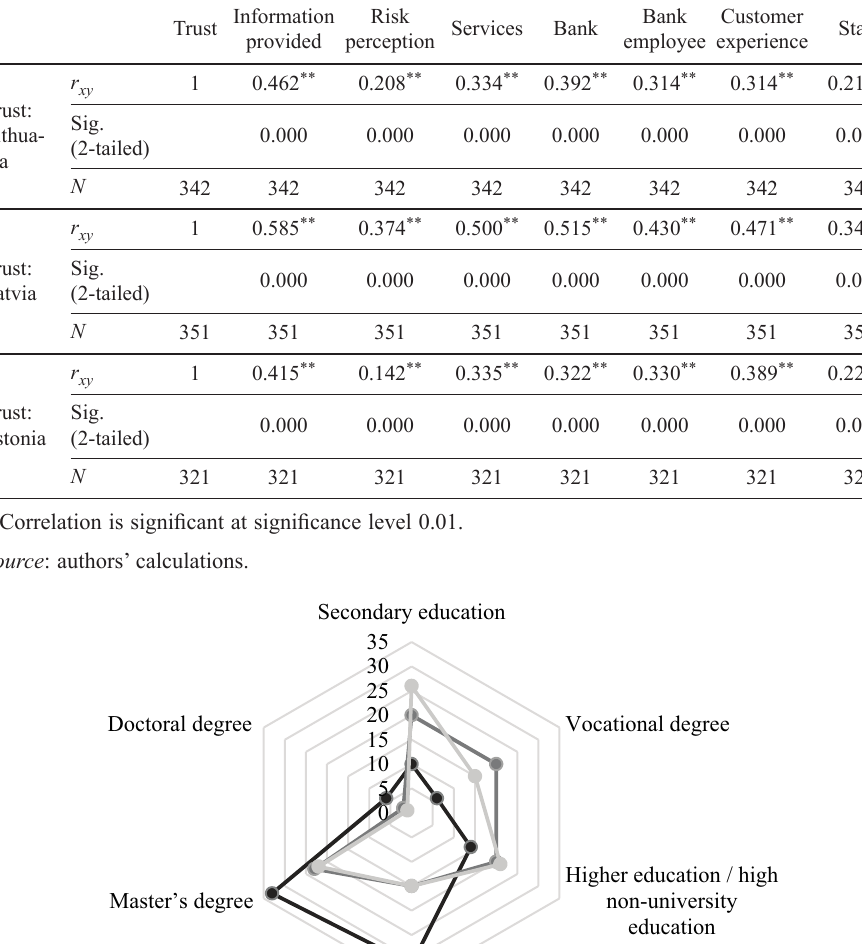
Table 1 represents correlation coefficient matrix of trust in traditional banking and its determinants in all three countries. Table 1. Correlation coefficients between distinguished factors and trust in traditional banking Information Trust